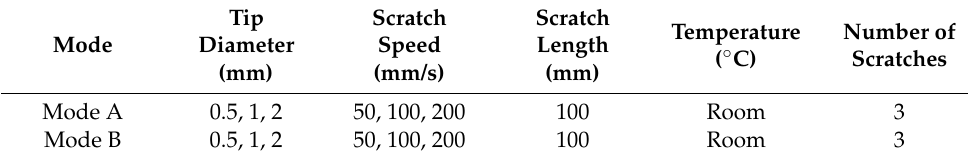
Table 1. Scratch test mode and test